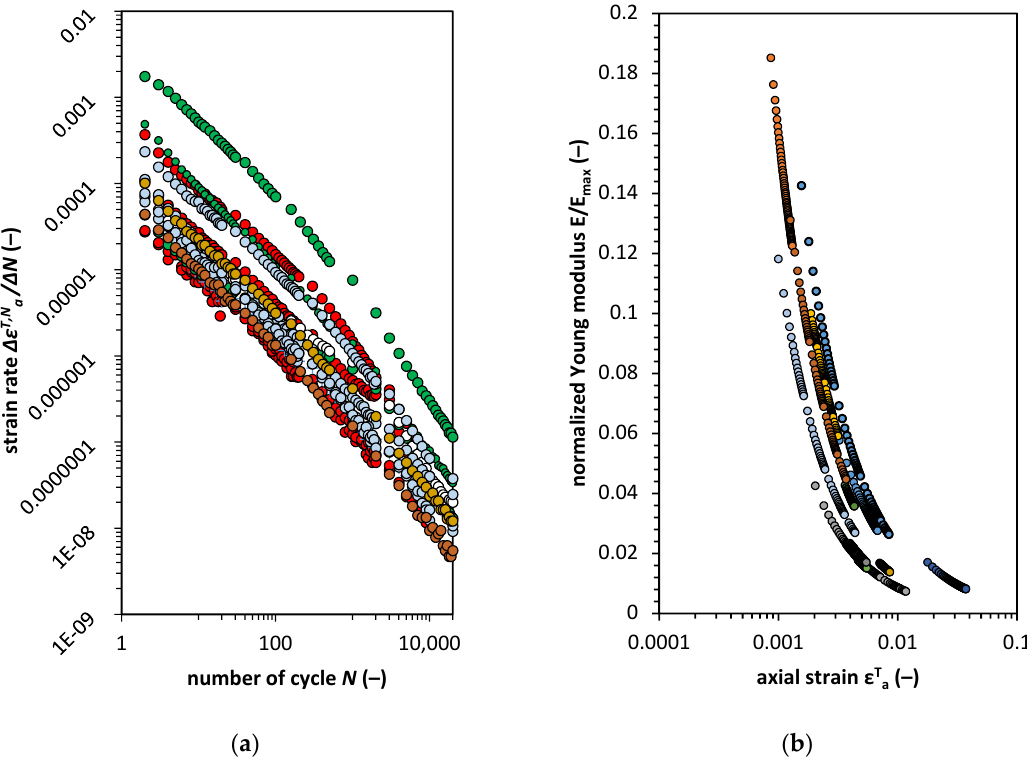
Figure 7. ( a ) Strain rate for tested soils for the following number of cycles; ( b ) normalized Young modulus characteristic versus maximal axial strain for samples loaded with cyclic force.